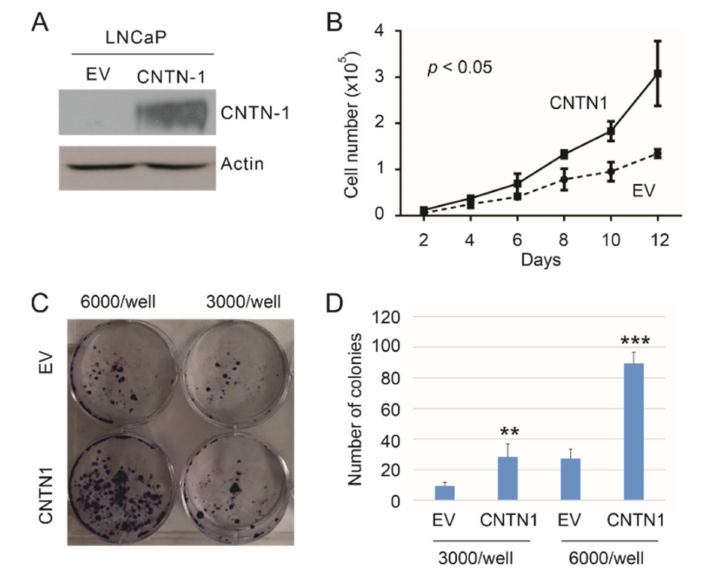
Figure 1. CNTN1 enhances LNCaP cell proliferation. ( A ) Western blot analysis for CNTN1 and Actin expression in the indicated stable lines. ( B ) LNCaP empty vector (EV) and LNCaP CNTN1 cells were seeded at 10 4 /well in 6-well plate. Cell numbers were counted every two days. Experiments were repeated three times. Mean ± SD (standard deviation) was graphed; 2-way ANOVA was used to analyze the two growth curves. ( C , D ) LNCaP EV and LNCaP CNTN1 cells were seeded in 60 mm plates at the indicated densities for colony formation. Experiments were repeated three times. Typical images from a single repeat are presented ( C ); quantifications were graphed using Mean ± SD. ** p < 0.01, *** p < 0.001 in comparison to the respective EV control by 2-tailed Student t-test ( D